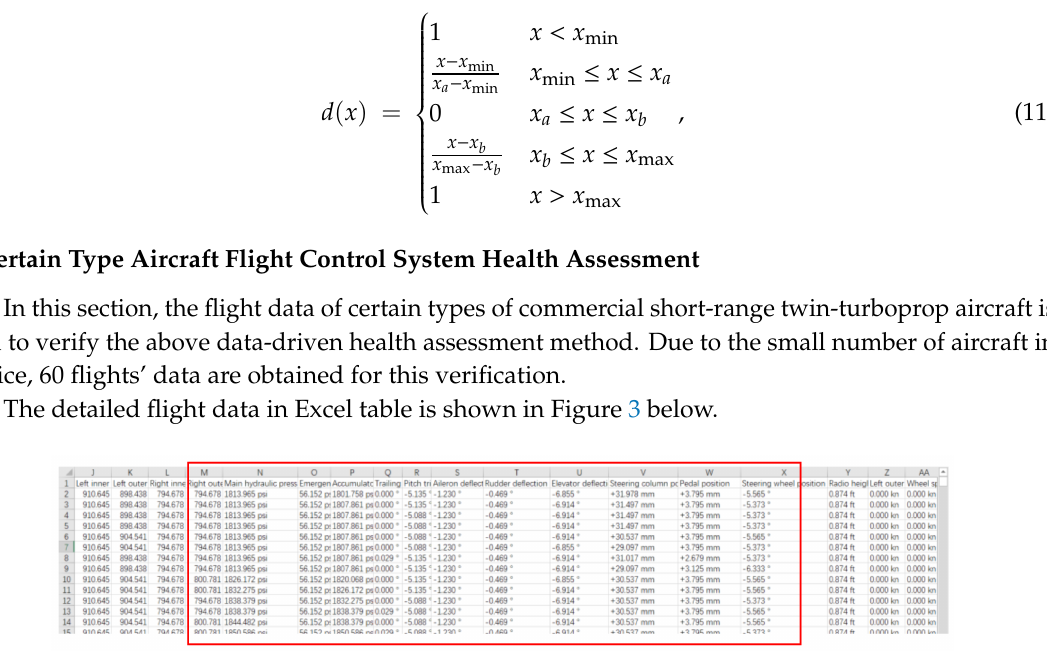
Figure 3. Flight data in Excel